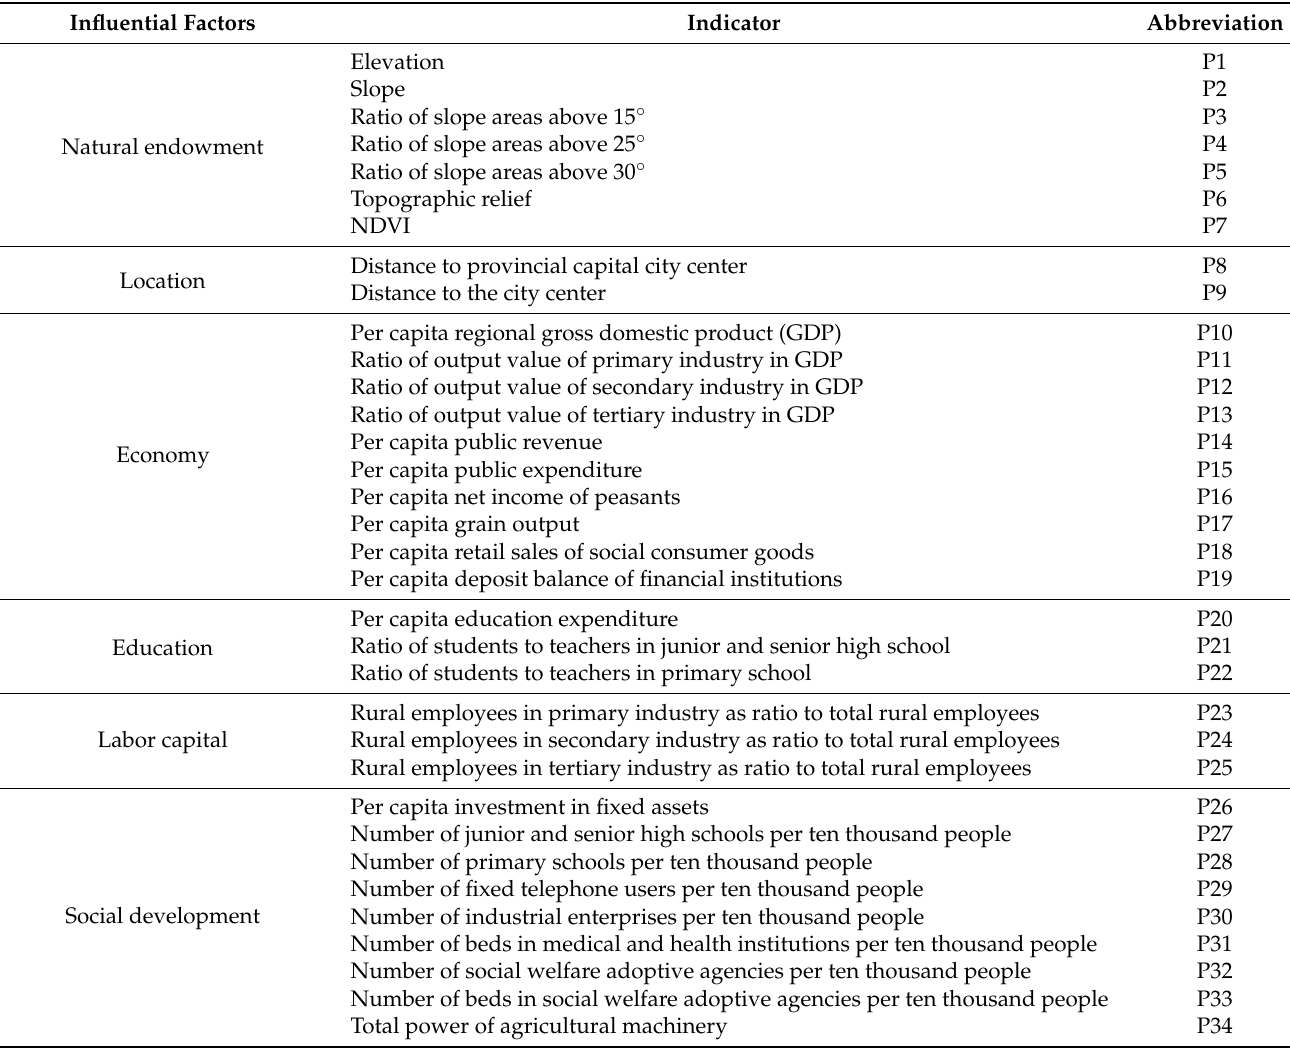
Table 1. Description of poverty influential factors in continuous poverty-stricken areas in